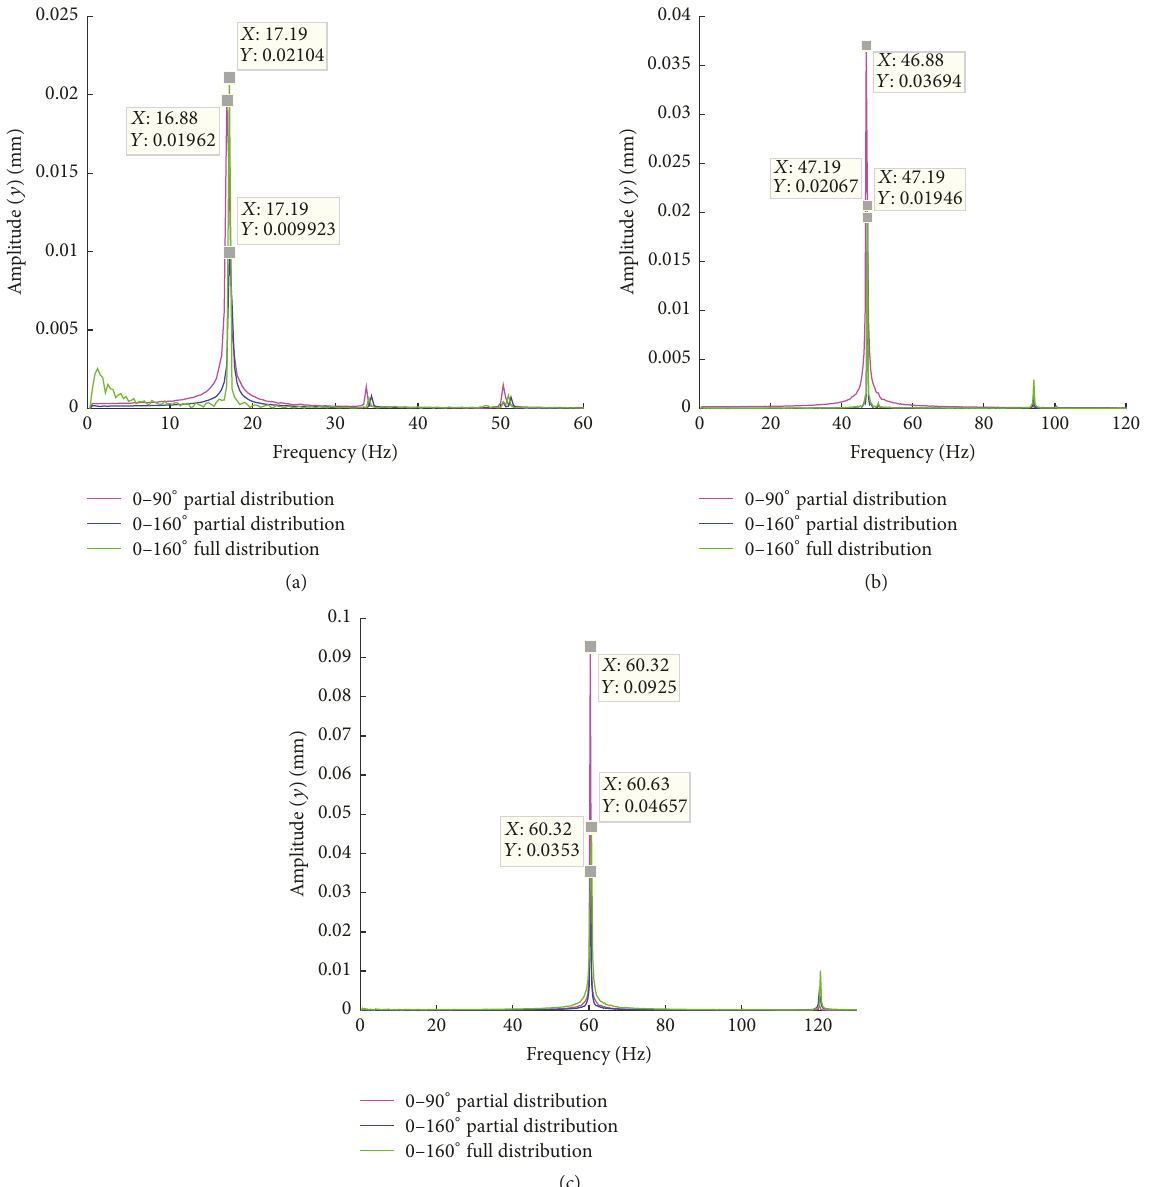
Figure 7: Comparison of spectrums at rotating speed: (a) 1000r/min; (b) 2800 r/min; (c) 3600 r/min.